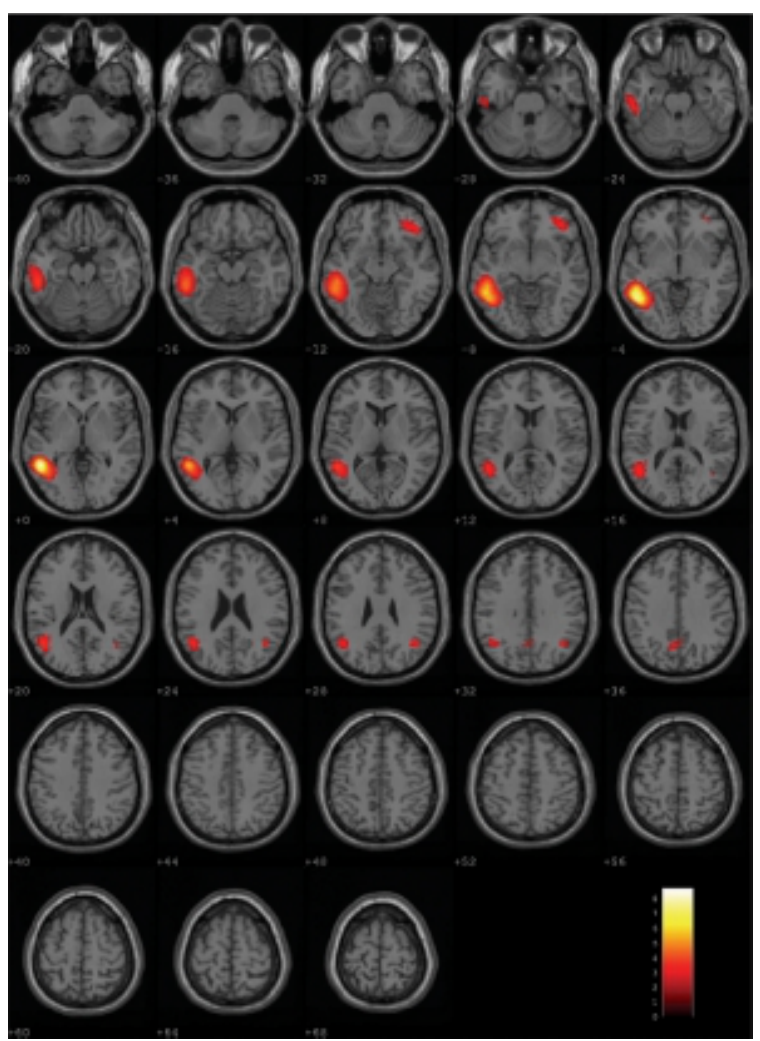
Fig. 1. Case 3 Statistical parametric maps (SPM99) showing: (A) hypoperfusion involving the left temporal